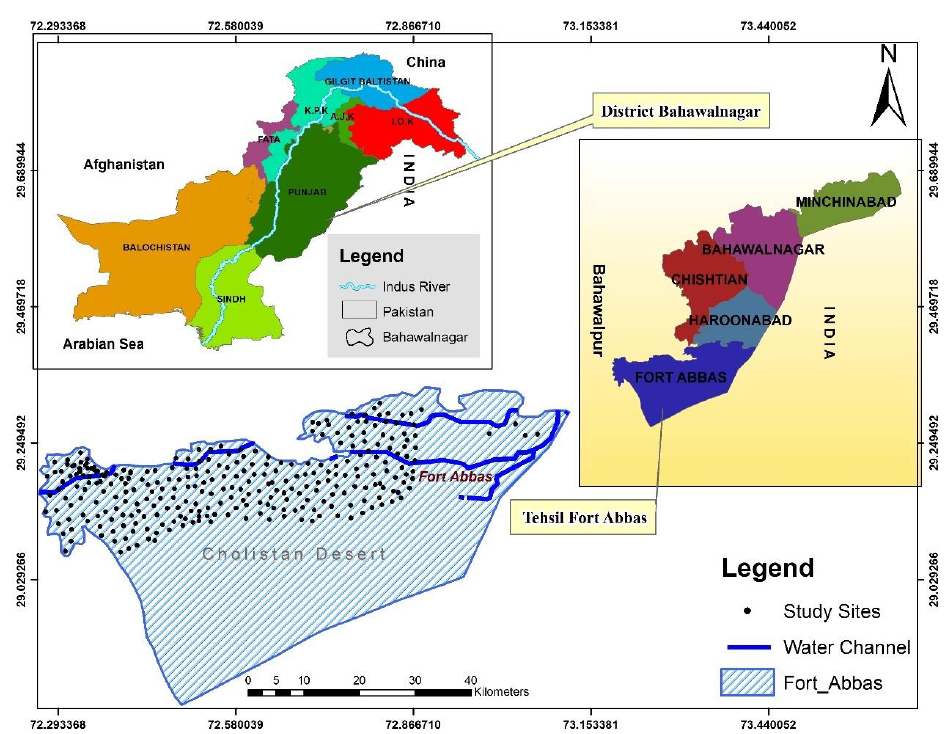
Figure 1. GIS locations of water sampling and cotton yield studied area.